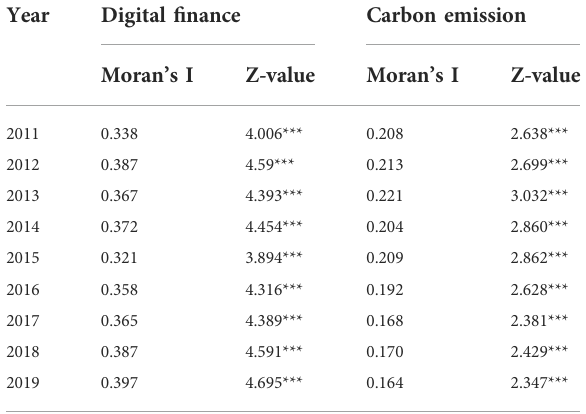
TABLE 2 Main variables Moran ’ s I